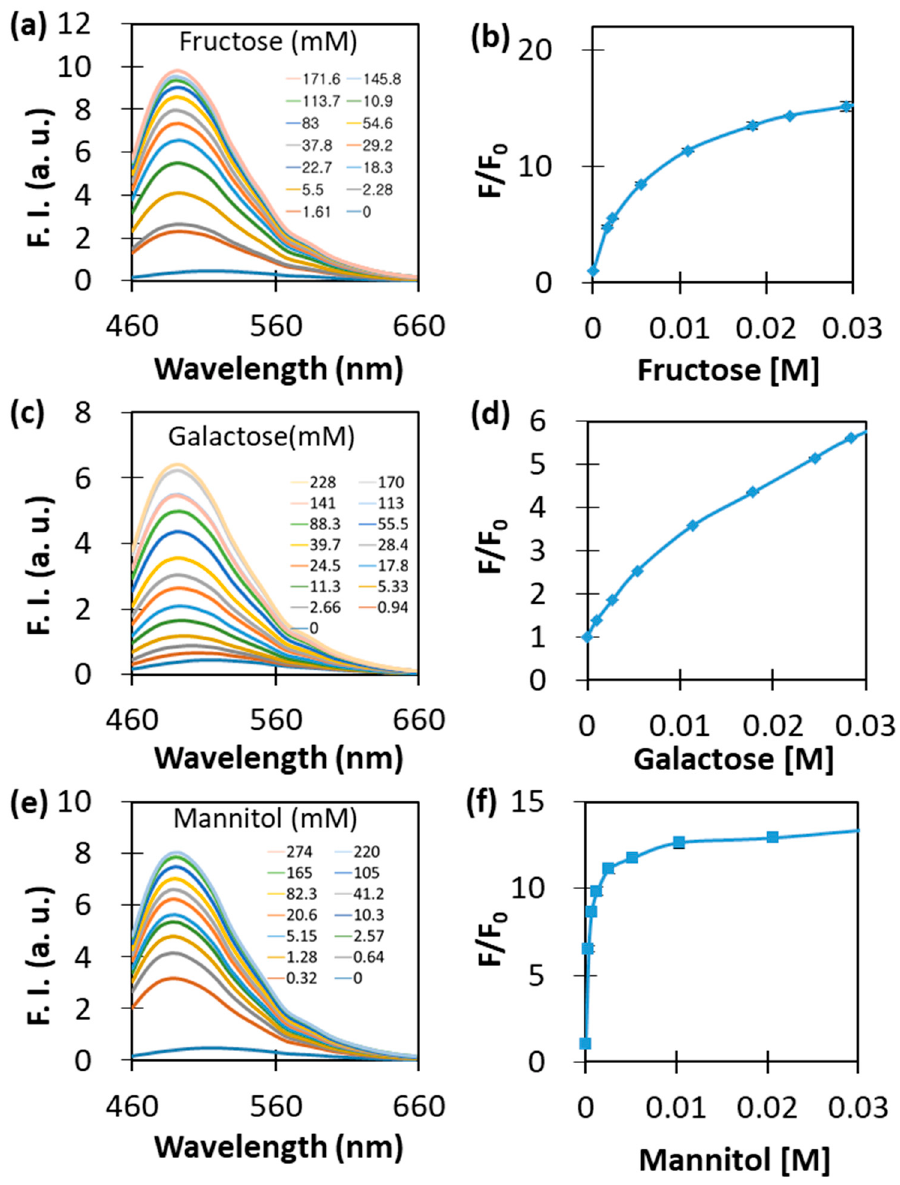
Figure 7. Binding properties of AcTDA with interferences. ( a , c , e ) Emission spectra for AcTDA with fructose, galactose, and mannitol, respectively. ( b , d , f ) Relative fluorescence intensity with fructose, galactose, and mannitol, respectively.